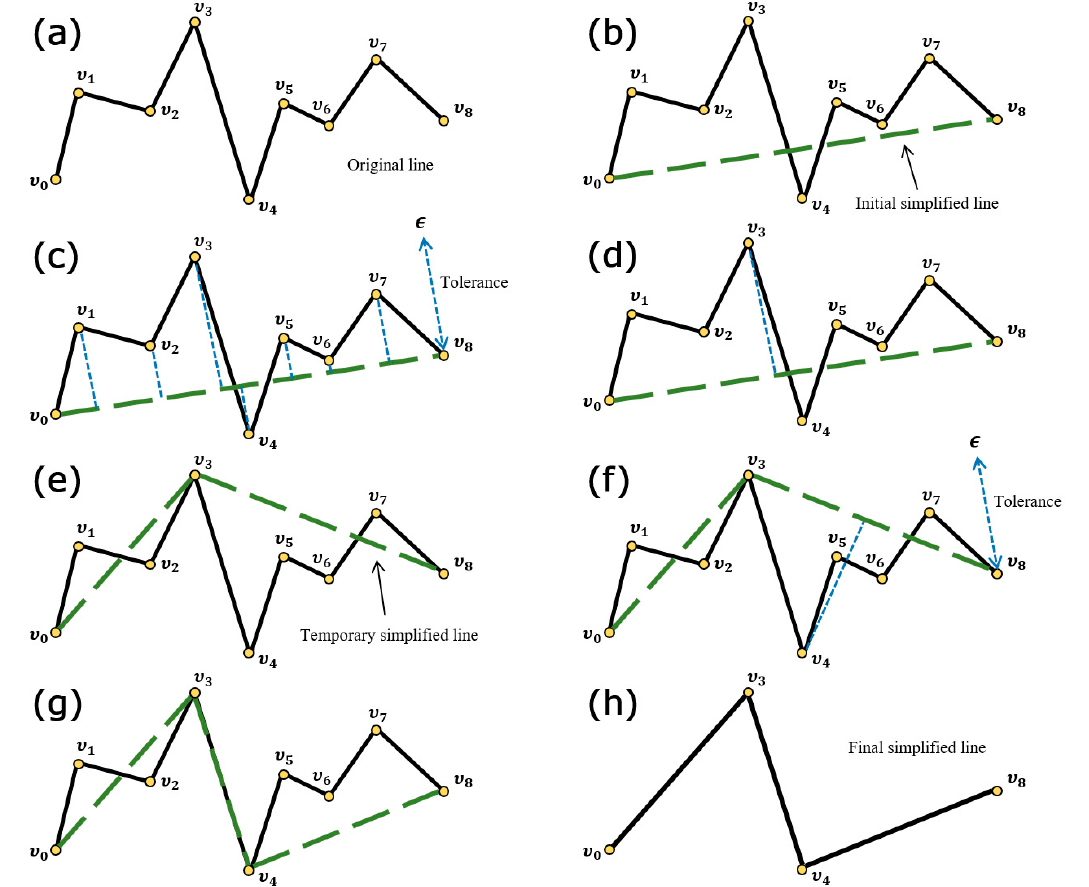
Figure 7. Procedure of line simplification using the Douglas-Peucker